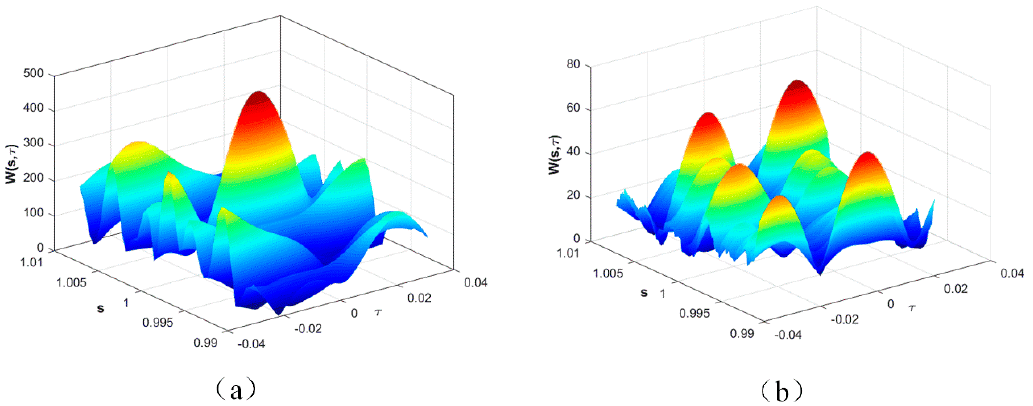
Figure 4. 3D plot of ambiguity functions of the temperature sensor response at 25 °C ( a ) and 100 °C ( b ) respectively.